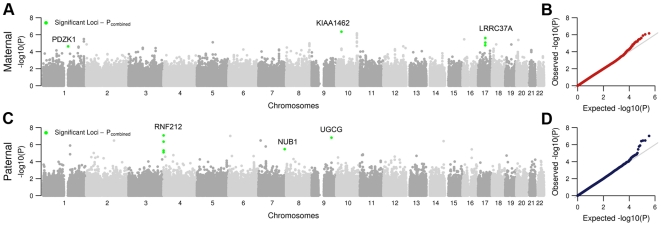
Results of genome-wide association studies of female and male recombination phenotypes.Results of analysis of the AGRE samples for females (A) and males (C) are shown. Combined P-values for the significant loci are plotted in green. Quantile–Quantile plots with observed P-values plotted as a function of expected P-values for female (B) and male (D) recombination phenotypes are shown.